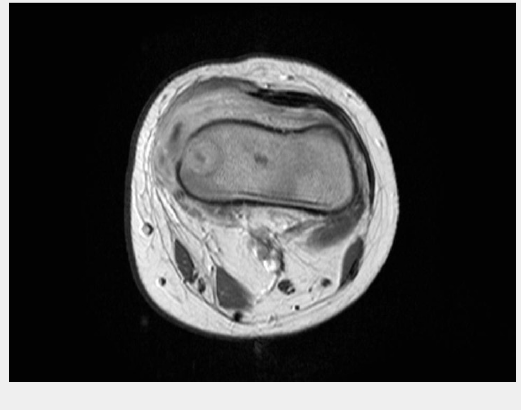
Magnetic resonance imaging (MRI) of the distal femur of a 17-month-old boy, which showed a normal appearance on plain radiographs. MRI demonstrated a lytic lesion of the distal femoral epiphysis with an important abscess of the soft surrounding tissues. Specific cultures confirmed